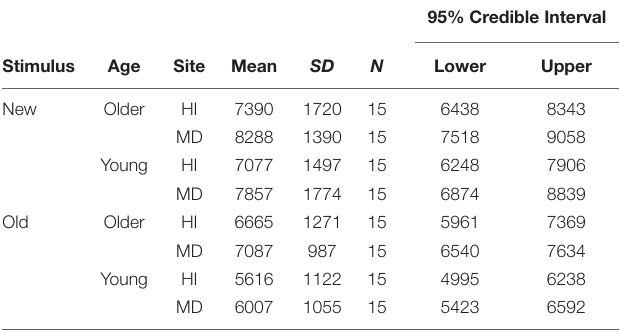
TABLE 4 | Descriptive statistics for response times of correctly solved CRA items.